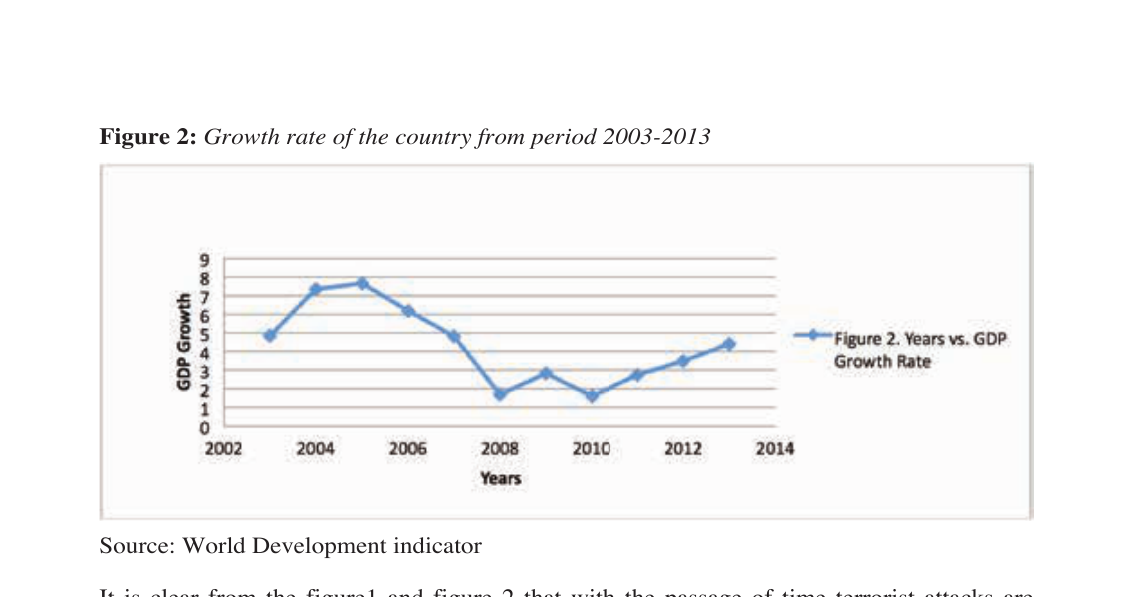
Figure 2: Growth rate of the country from period